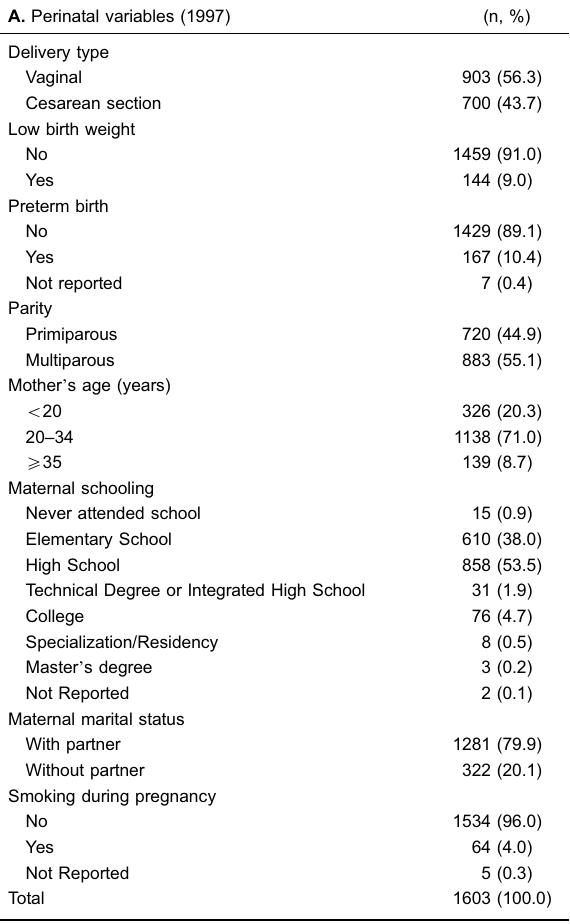
Table 1. Perinatal, sociodemographic, and economic character- istics of adolescents and maternal socioeconomic conditions. A. Perinatal variables